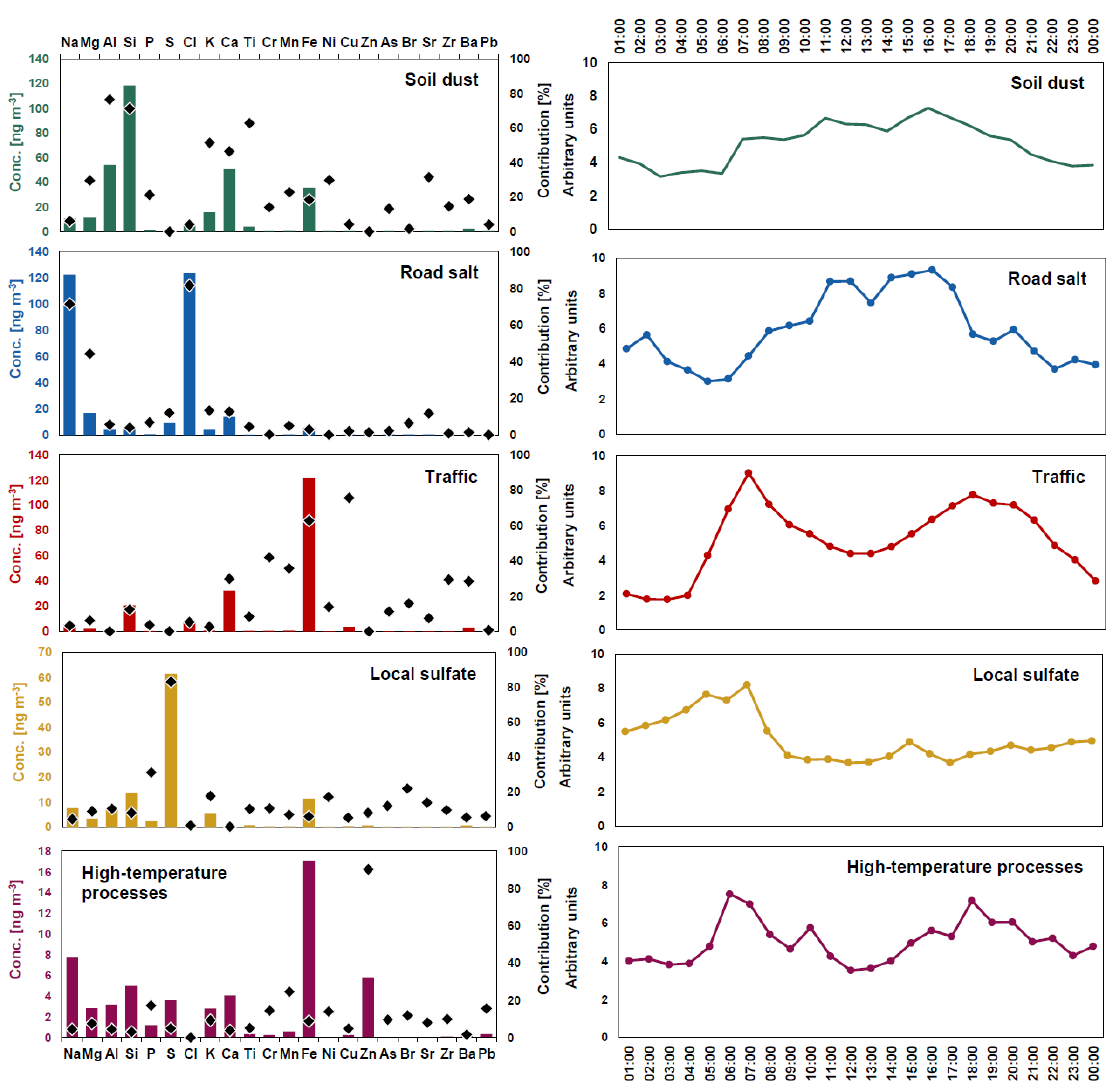
Figure 5. The left column shows the PMF profiles (bars; left y axis) and contributions (black diamonds; right y axis) of the identified sources for the coarse fraction. The right column shows the daily patterns of the identified sources (in arbitrary